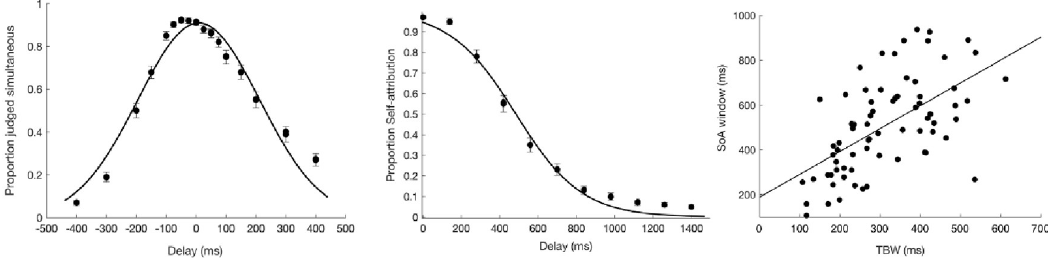
Fig 3. Relationship between TBW and SoA window. (A) Across-participants average probability of judging the stimuli as simultaneous plotted as a function of the delay. The curve represents the Gaussian fit determining the amplitude of TBW, corresponding to the standard deviation of the Gaussian curve. The points represent across-participants average raw data with error bars showing standard error of the mean. (B) Across-participants average probability of self-attribution plotted as a function of the delay. The curve represents the sigmoid fit determining the amplitude of the SoA window corresponding to the inflection point of the sigmoid. The points represent across-participants average raw data with error bars showing standard error of the mean. (C) Linear correlation between TBW (simultaneity judgment task) and the SoA window (judgment of agency